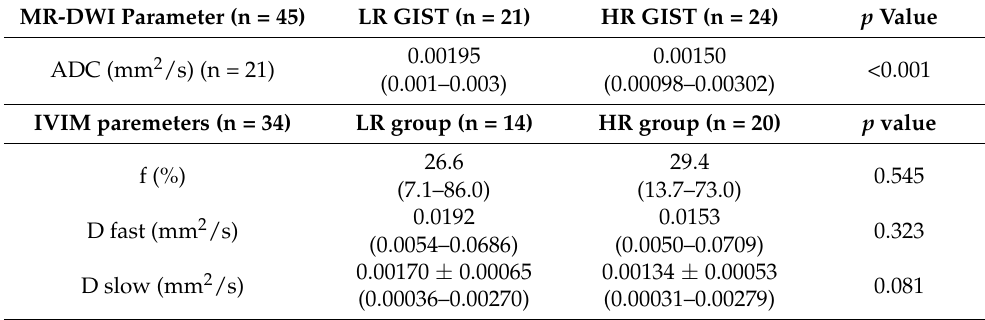
Table 3. MR-DWI (ADC and IVIM) parameter values of gastric GIST in HR and LR group.